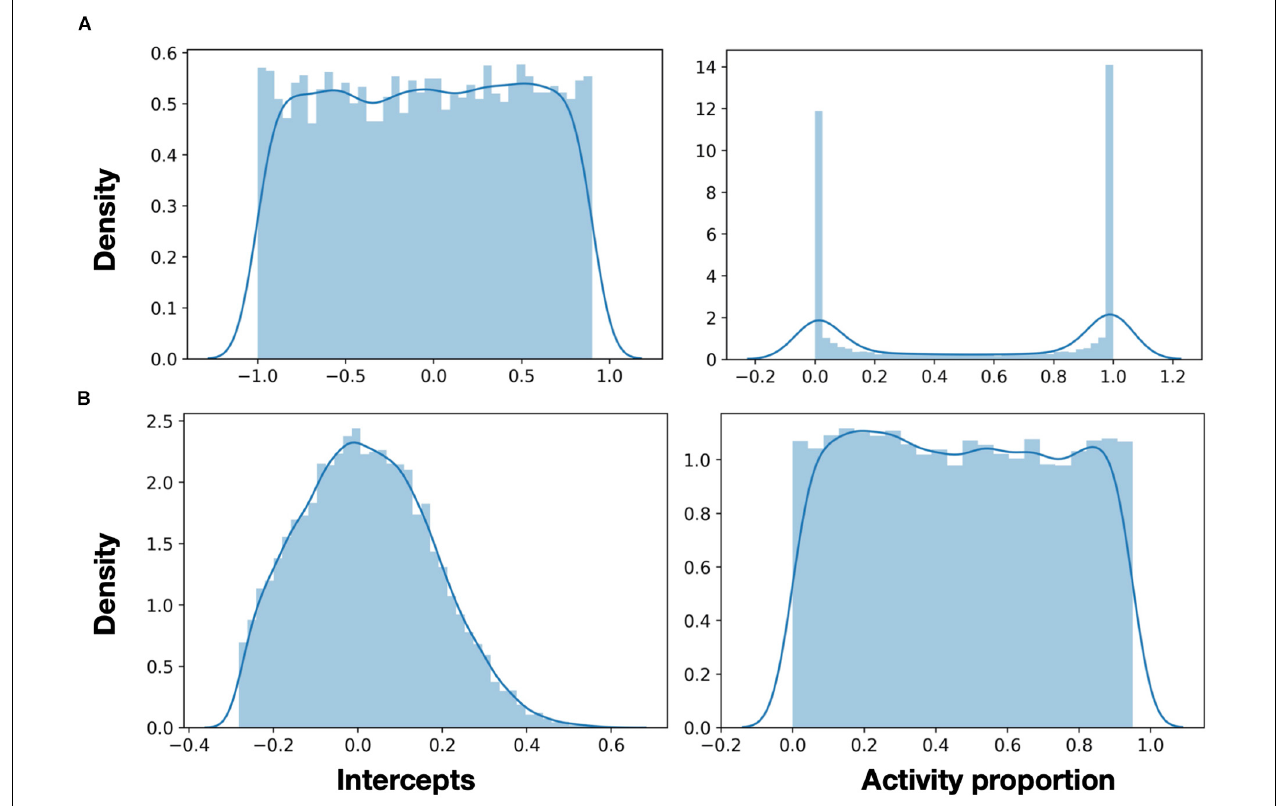
FIGURE 6 | Neurons activity in high dimension. (A) In 32D representation, a uniform distribution of intercepts (left) creates many neurons, which are either always or never active (right). (B) Using a rational distribution of intercepts (using Eq. 7), a uniform activity pattern of neurons across the representation space can be